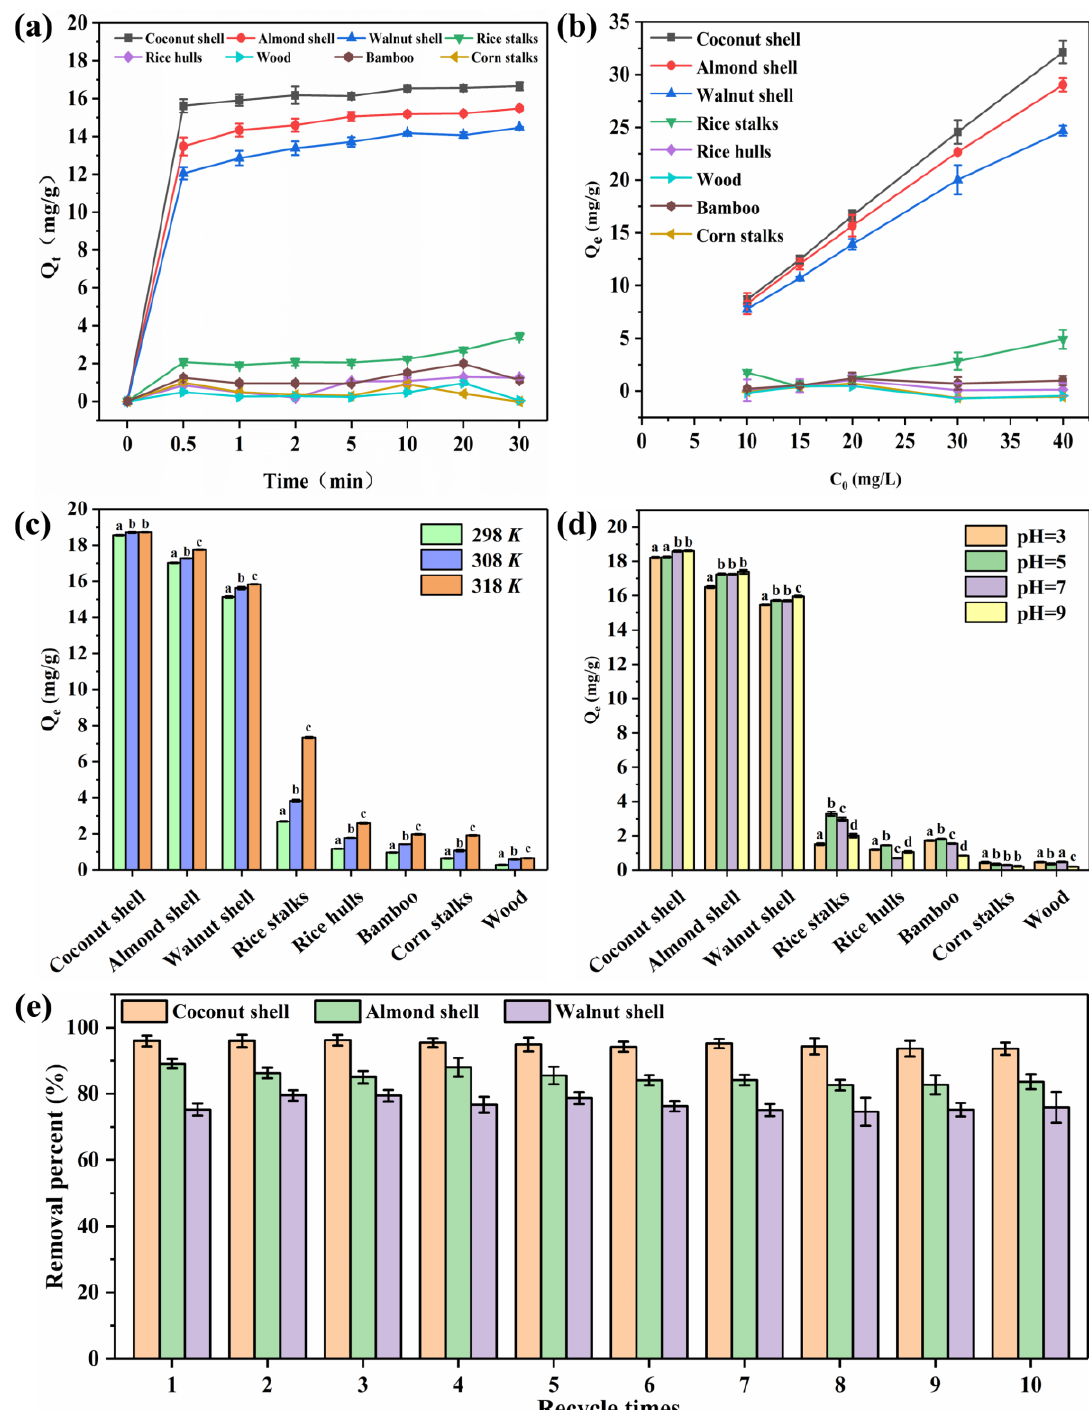
Figure 2. ( a ) Adsorption kinetics of profenofos on biochars; effects of initial adsorbate concentration ( b ), temperature ( c ), pH ( d ) on the adsorption of profenofos; ( e ) recycling of nutshell biochars. All values are means ± standard deviation of triplicate measurements. Mean values with the same letter (a, b, c, d) are not significantly different from temperature (298 K , 308 K , 318 K ) and pH (3, 5, 7, 9) by LSD at the 5% level.